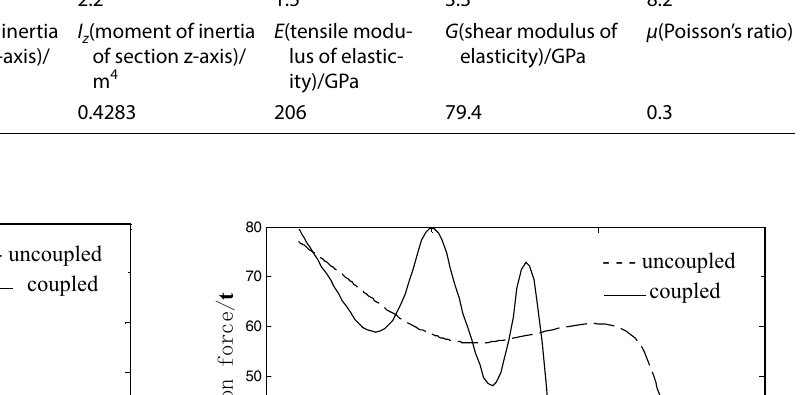
Table 4 Main dimension of standard beam section